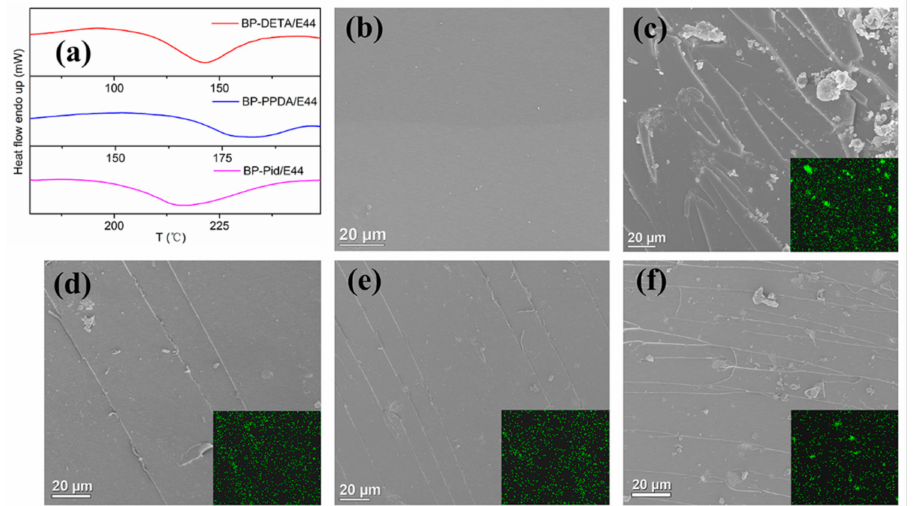
Figure 4. ( a ) DSC thermograms of BP-NH 2 /E44; SEM images of freeze-fractured surface for ( b ) pure EP, ( c ) EP/BP (5 wt%), ( d ) EP/BP-DETA (5 wt%), ( e ) EP/BP-PPDA (5 wt%), ( f ) EP/BP-Pid (5 wt%) nanocomposites and the corresponding P element distribution